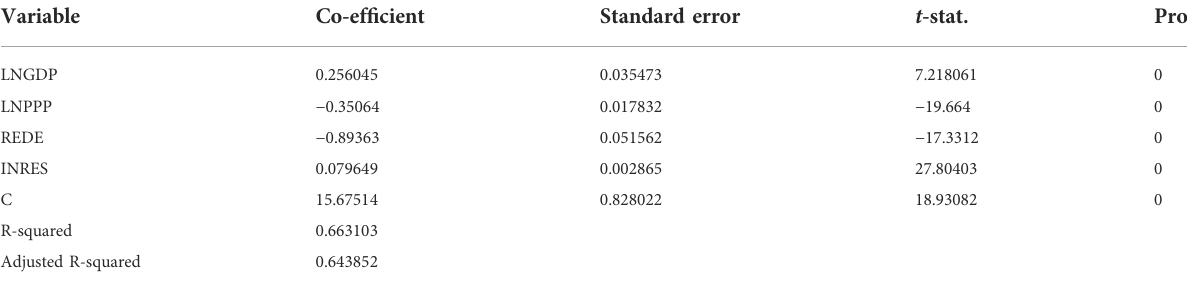
TABLE 5 White cross-section panel EGLS (period random effects).